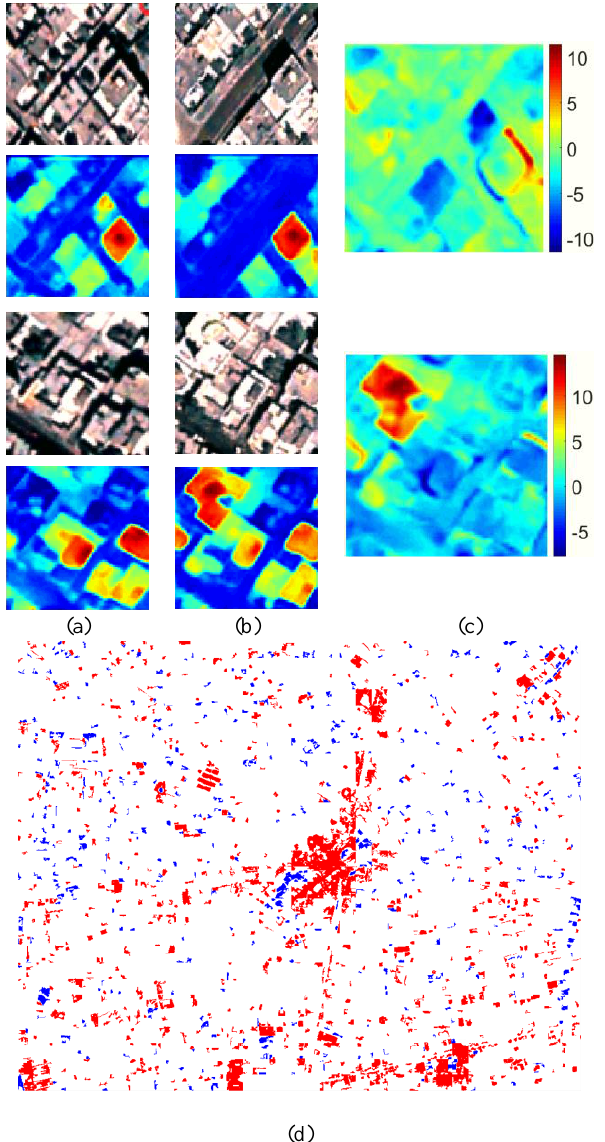
Figure 7. Some samples of the change detection, (a) the data of the 2006, (b) the data of the 2012, (c) the result of change detection, and (d) the positive and negative changed regions by applying a threshold (4 m) for the whole of the study area.